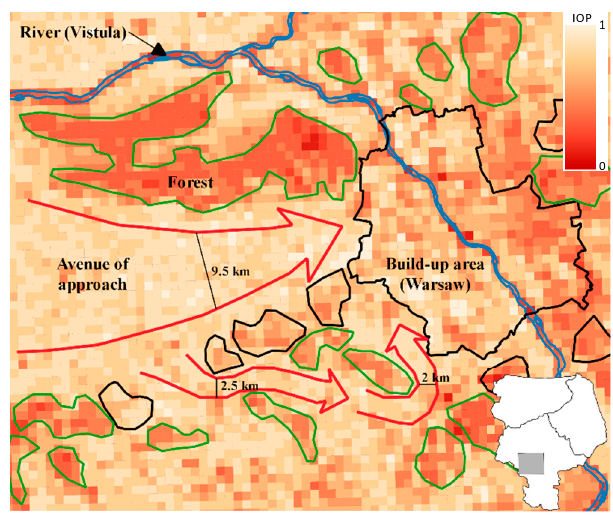
Figure 10 . Part of a passability map generated using a primary field of 1000 × 1000 m with avenues of approach and the most significant elements of land cover.